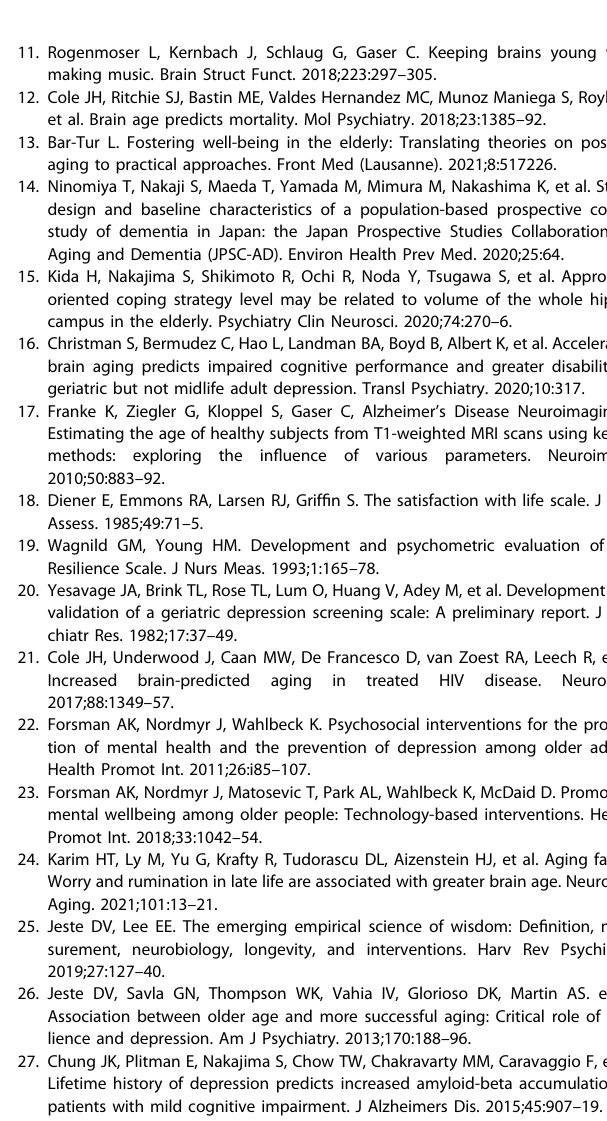
c Categorized absence as ‘ 0 ’ and presence as ‘ 1.